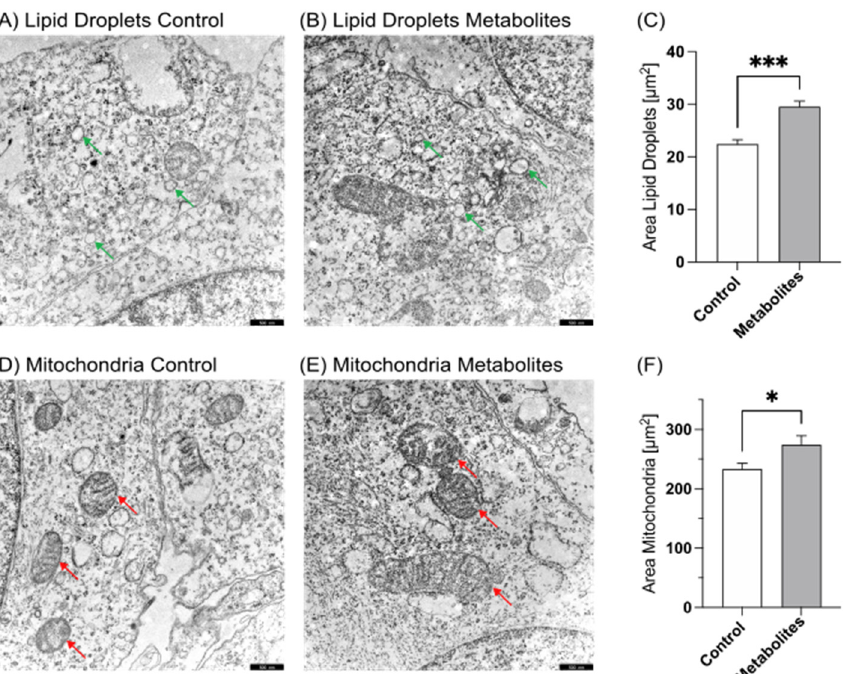
Figure 2. Transmission electron microscopy of SH-SY5Y wild-type cells. ( A ) Control-treated SH-SY5Y cells at 12,000 × magnification. Green arrows mark lipid droplets. ( B ) SH-SY5Y cells treated with aspartame metabolites at 12,000 × magnification. Green arrows mark lipid droplets. ( C ) Comparison of the area of lipid droplets in control- and aspartame metabolite-treated cells in a bar chart. Error bars represent the standard error of the mean (SEM). The statistical significance was set as *** p ≤ 0.001. ( D ) Control-treated SH-SY5Y cells at 12,000 × magnification. Red arrows show mitochondria. ( E ) SH-SY5Y cells treated with aspartame metabolites at 12,000 × magnification. Red arrows show mitochondria. ( F ) Comparison of the area of mitochondria in control- and aspartame metabolite-treated cells. Error bars represent the standard error of the mean (SEM). The statistical significance was set as * p ≤ 0.05. Scale bars for ( A , B , D , E ): 500